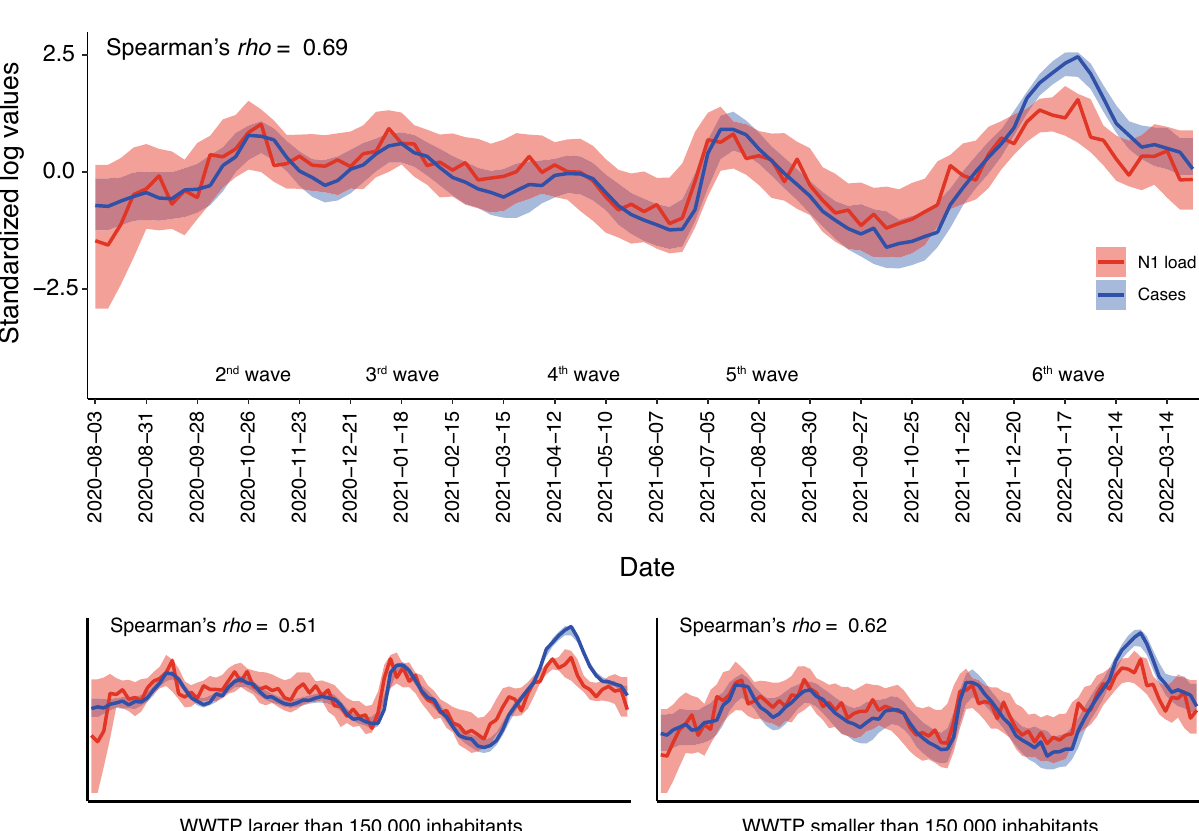
Figure 4. Timeline of SARS-CoV-2 standardized load in sewage (red) and diagnosed COVID-19 cases (blue) for each sampling data across all WWTP monitored. Shadowed ribbons represent the correspondent standard deviation values for each sampling date. The standard deviation values for each sampling date were smoothed using a rolling average with a window of 3 observations. The bottom plots show the same timeline when segregating viral loads and cases for large (> 150.000 inhabitants, left) and small (< 150.000 inhabitants, right) WWTPs. Values of Spearman Rho correlation coefficients are also shown. Case data have been obtained from the Information Systems of the Department of Health and the Catalan Health Service 34